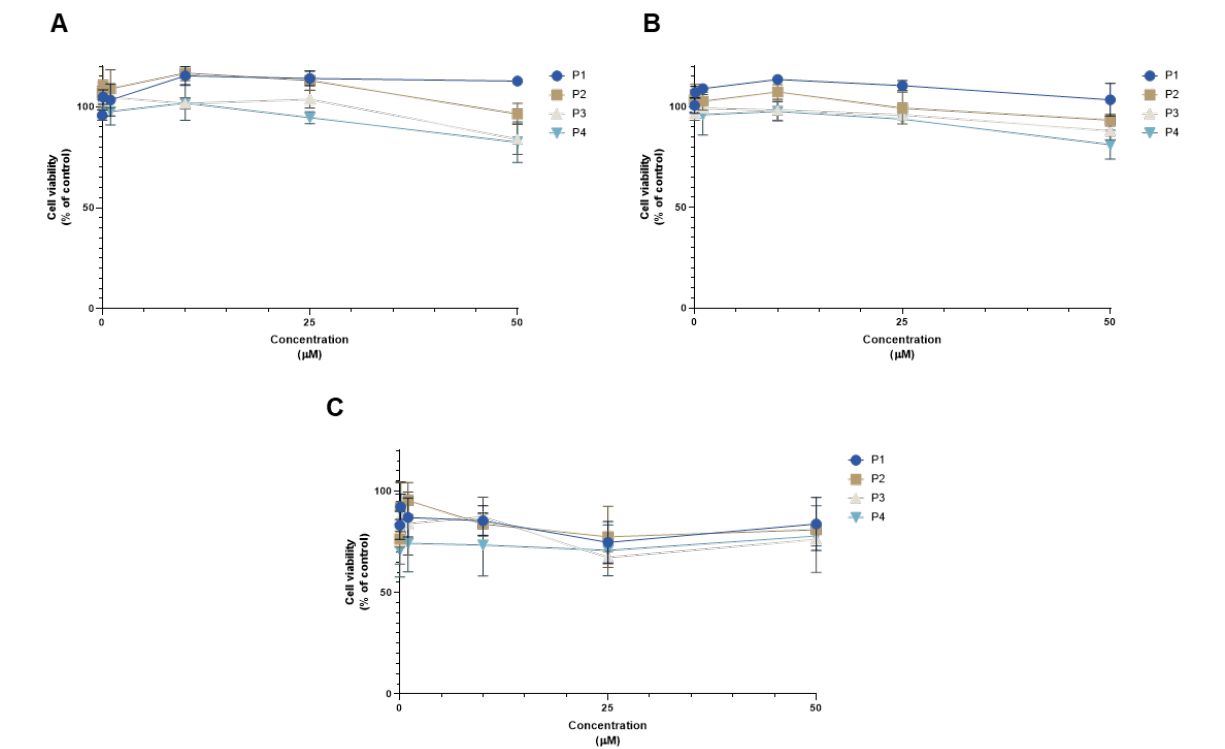
Figure 15. Comparison of cell viability results of ( A ) MCF-7, ( B ) HT-29, and ( C ) PC-3 cells after exposure to increasing concentrations of the peptides P1 – P4 (0.01 – 50 μM) for 48 h. Control cells were treated with 0.01% DMSO (vehicle). Cell viability was obtained using the MTT assay, and the results are given as the mean ± SEM ( n = 3).